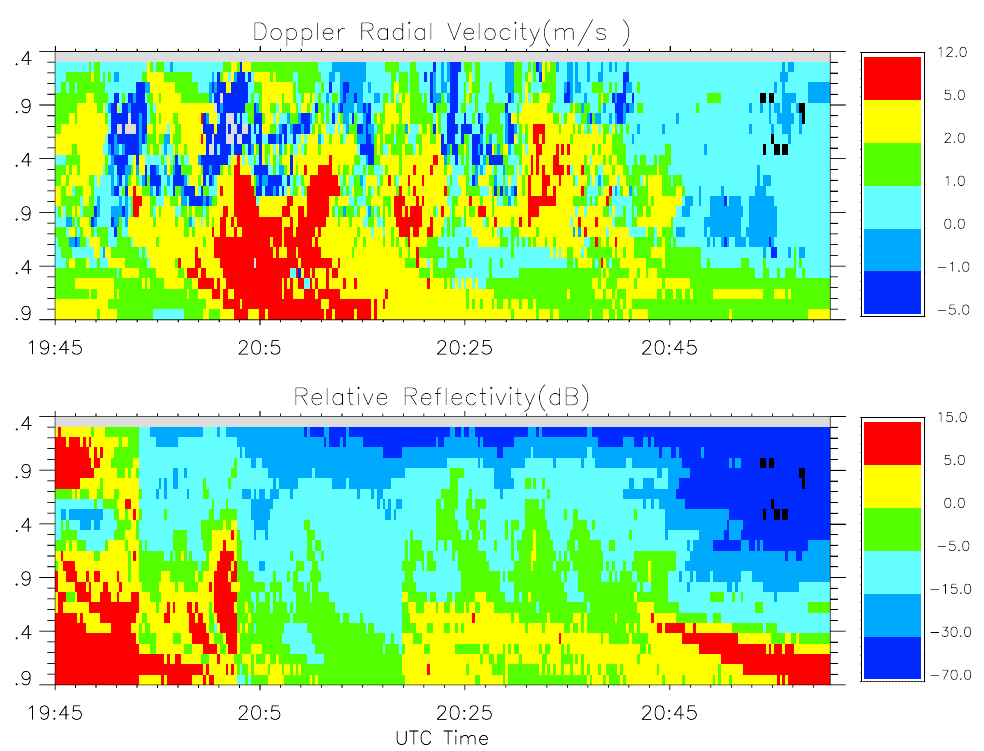
Fig. 3. UHF Strato-tropospheric radar: the lower plot represents the relative reflectivity in color scale (relative dB) as a function of altitude and time; the upper plot represents the Doppler velocity in the vertical beam in color scale (m/s) as a function of altitude and time; positive values correspond to upward